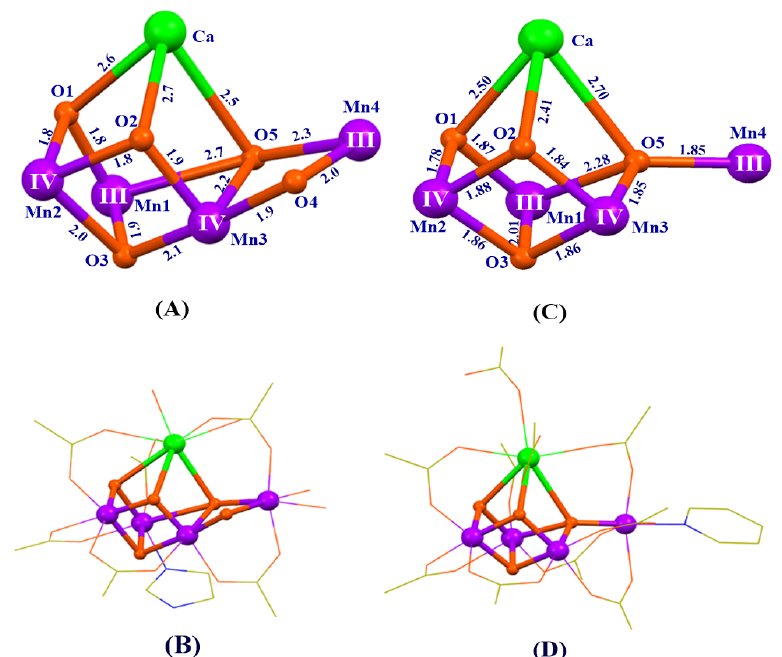
Figure 9. Structures of the natural OEC [50] ( A , B ) and the artificial Mn 4 Ca-cluster [118] ( C , D ). Distances are given in Å units. Mn, Ca, O, N and C are shown in purple, green, orange, blue, and yellow, respectively. The oxidation states of the four manganese ions in A are directly taken from the previous suggestion [50], which are different from the BVS calculations listed in Table 1. For clarity, all the methyl groups and hydrogen atoms are not shown.